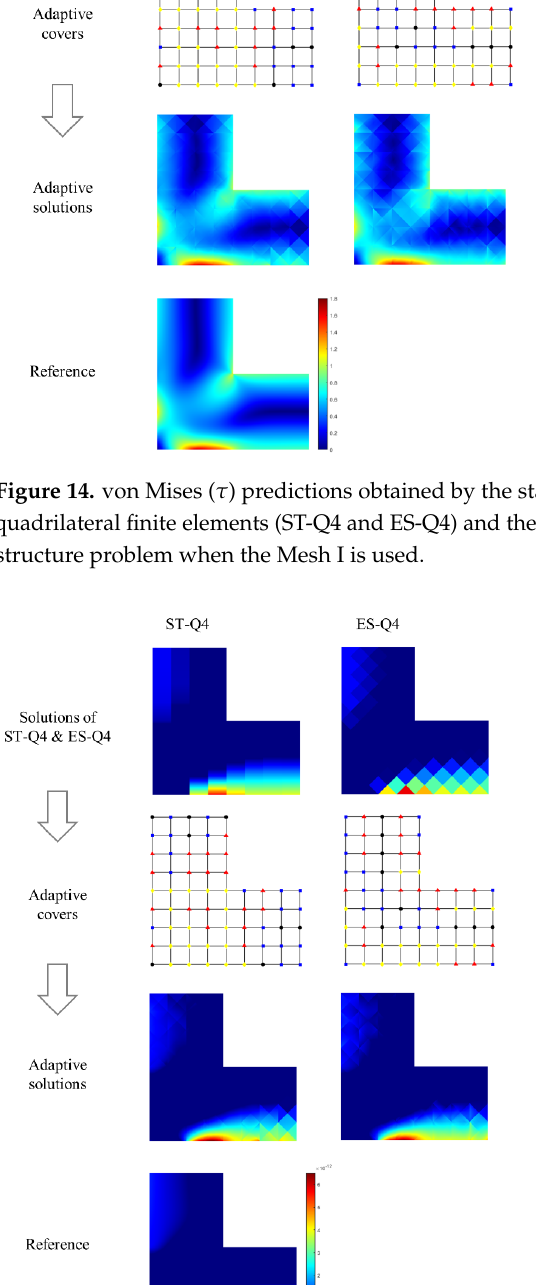
Figure 15. Strain ( ε xx ) predictions obtained by the standard and edge-based smoothed four-node triangular finite elements (ST-Q4 and ES-Q4) and the adaptive enrichment scheme for the L-shape structure problem when the Mesh I is used. Table 6. Relative errors (%) in the energy norm ( E ) and the maximum von Mises stress ( τ ) in the L-shape structure problem when the meshes of triangular elements (ST-T3, ES-T3) are used. e [%] e τ [%] E